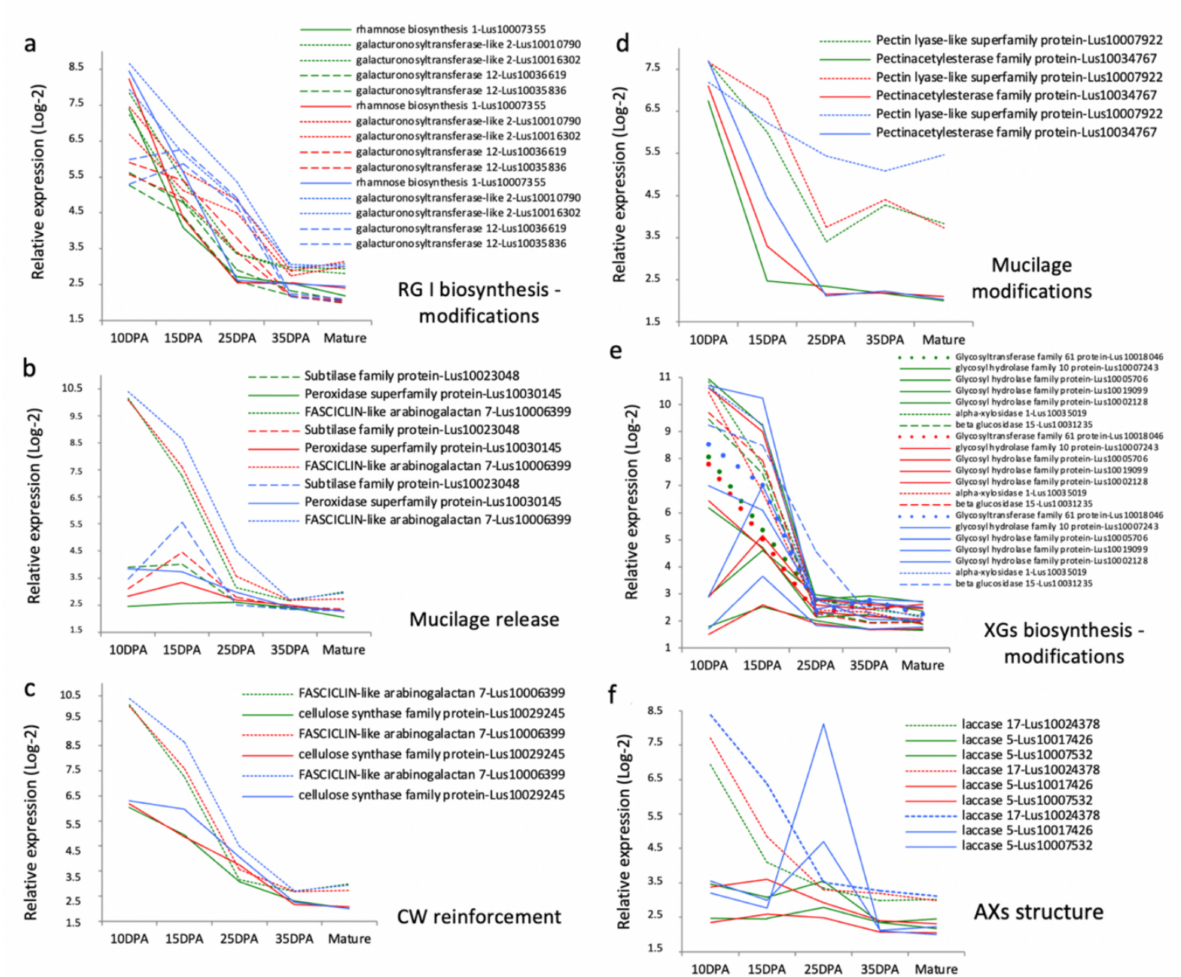
Figure 4. Expression patterns of the genes involved in the chemical composition of the mucilage and related processes. Genes are selected as especially differentially expressed between RIL 44 and 283 vs. RIL 80 in whole Scheme 10. DPA) and seed coat tissues. Selected genes are classified in six different categories according to their putative roles based on literature. For each one, the corresponding parallel coordinates plot displays the relative gene signal intensity according to the stages of development. The relative signal intensity represents the lsmean (Log2 transformed) of the raw data extracted from the oligo microarrays analysis. Data are lsmeans of three biological replicates. Each of the genes is associated with its corresponding gene-ID. The FASCICLIN-like AGP 7 was included in two categories according to the literature. RIL 283 is shown in green, RIL 44 in red and RIL 80 in blue. The format of the lines in each plot was chosen to improve data visualization. ( a ) RG I: Rhamnogalacturans biosynthesis modifications; ( b ) Mucilage release; ( c ) CW: Cell Wall reinforcement; ( d ) Mucilage modifications; ( e ) XGs: Xyloglucans biosynthesis modifications; ( f ) AX: Arabinoxylans